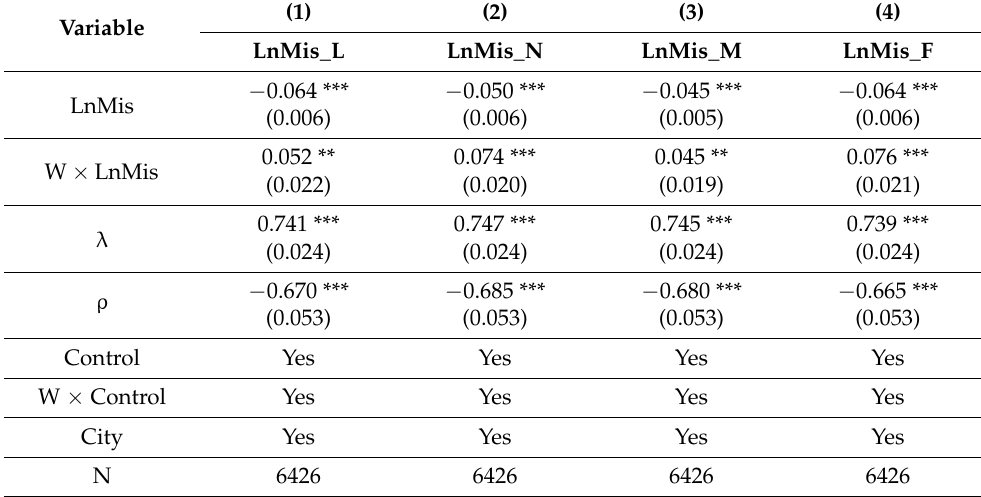
Table 9. Robustness test